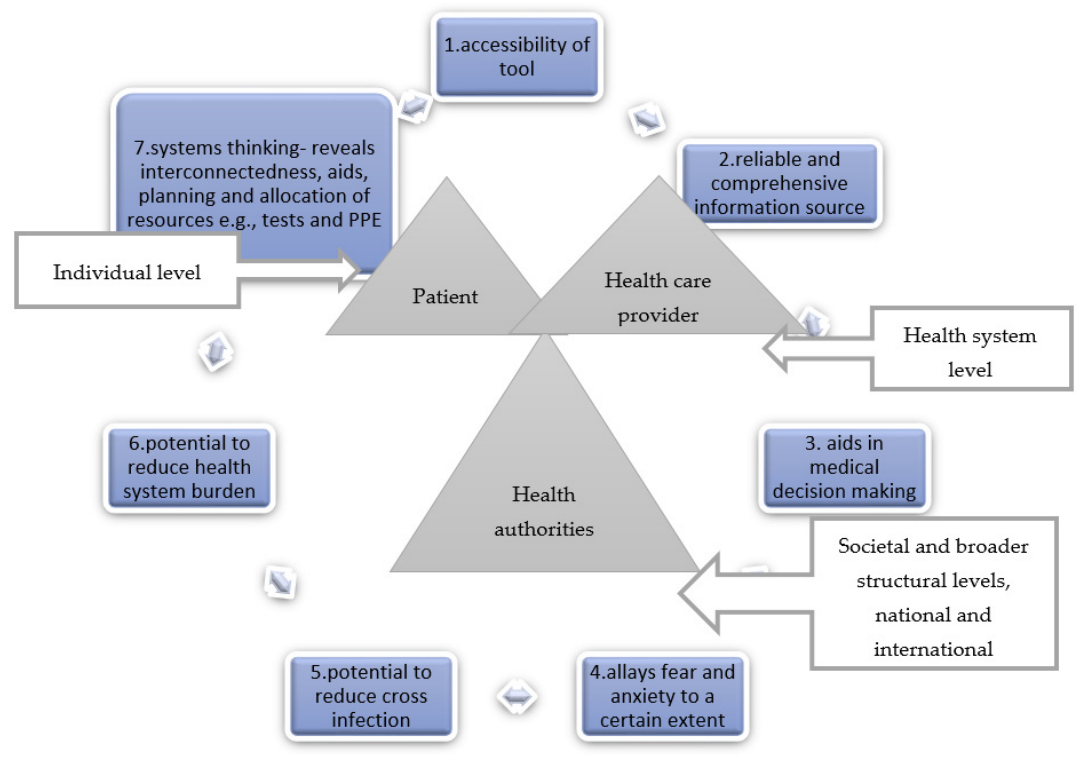
Figure 2. COVID-19 OFTT Utility Framework. Table 3. COVID-19 OFTT